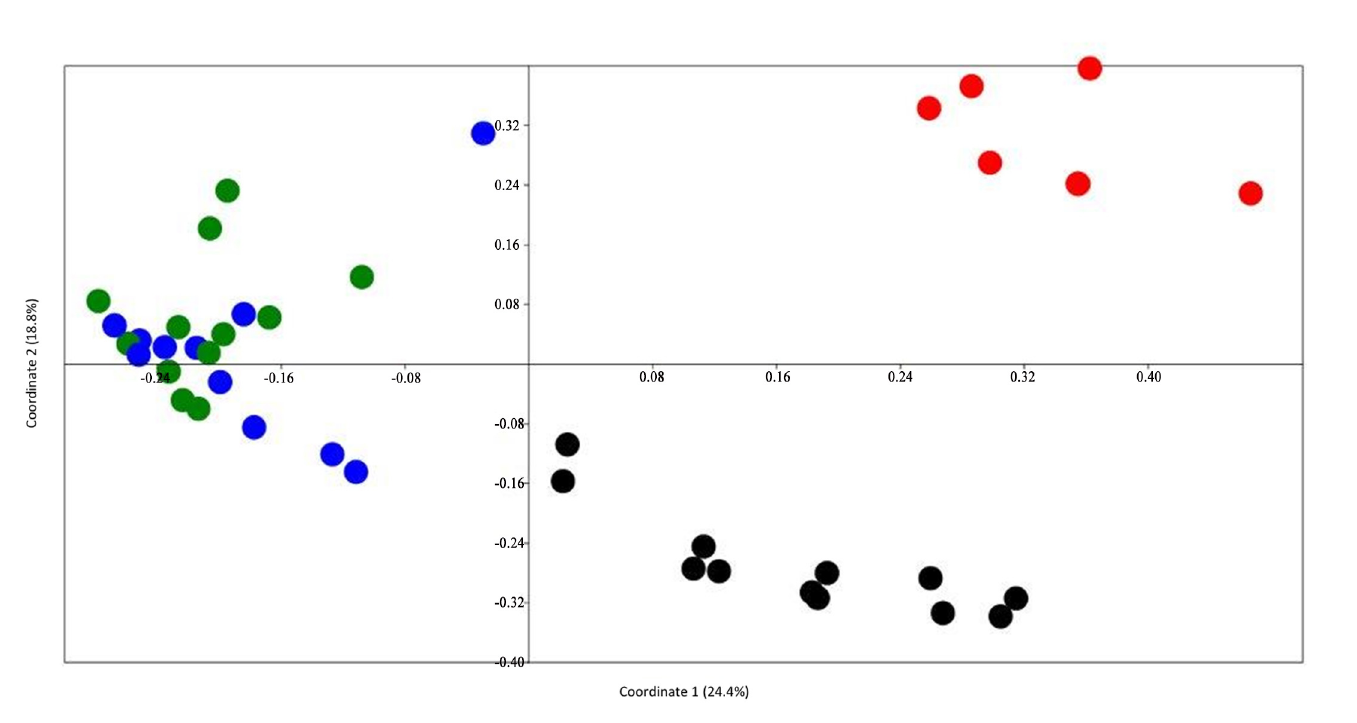
Fig 3. Principal coordinate analysis showing the clustering of antimicrobial resistance genes by livestock, municipal and low impact environmental samples. Antimicrobial resistance genes were detected among cattle (n = 12), low impact environment (n = 8), municipal (n = 12) and swine (n = 12) pooled samples. Data points are colored as follows: green = cattle, red = low impact environment, black = municipal and blue = swine.